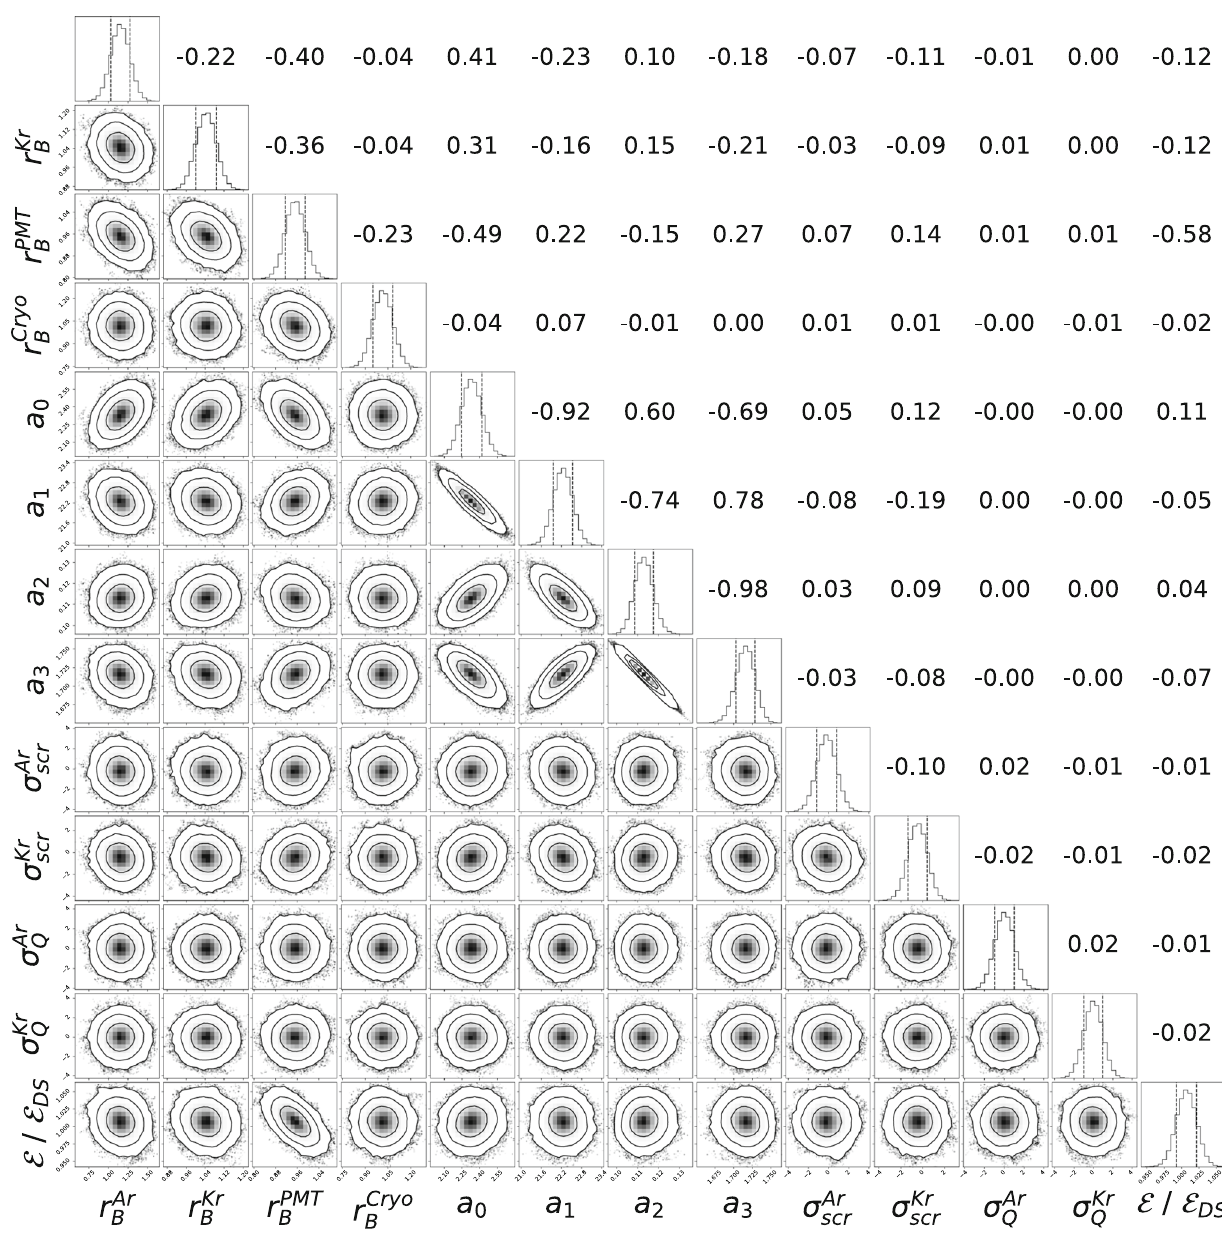
Fig. 12 Graphical representation of the joint posterior pdf of the back- ground only fit on the DS-50 observed dataset. The plots on the diago- nal of the figure are the uni-dimensional pdf of each single parameter obtained by marginalizing on all the others. The bi-dimensional pdf s in the bottom-left corner of the figure give the joint pdf s of each pair of